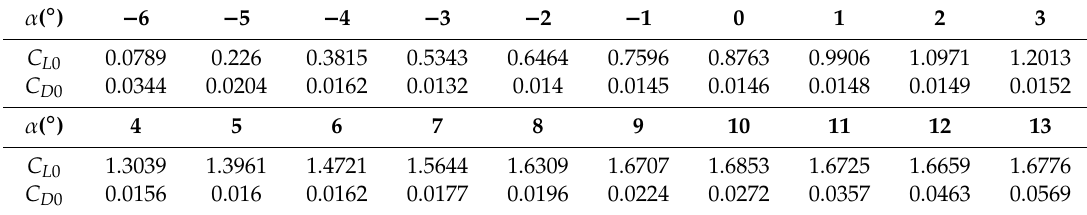
Table 1. The airfoil coe ffi cient of lift and